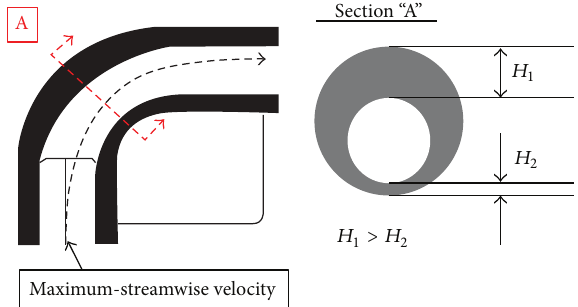
Figure 3: The effect of maximum streamwise